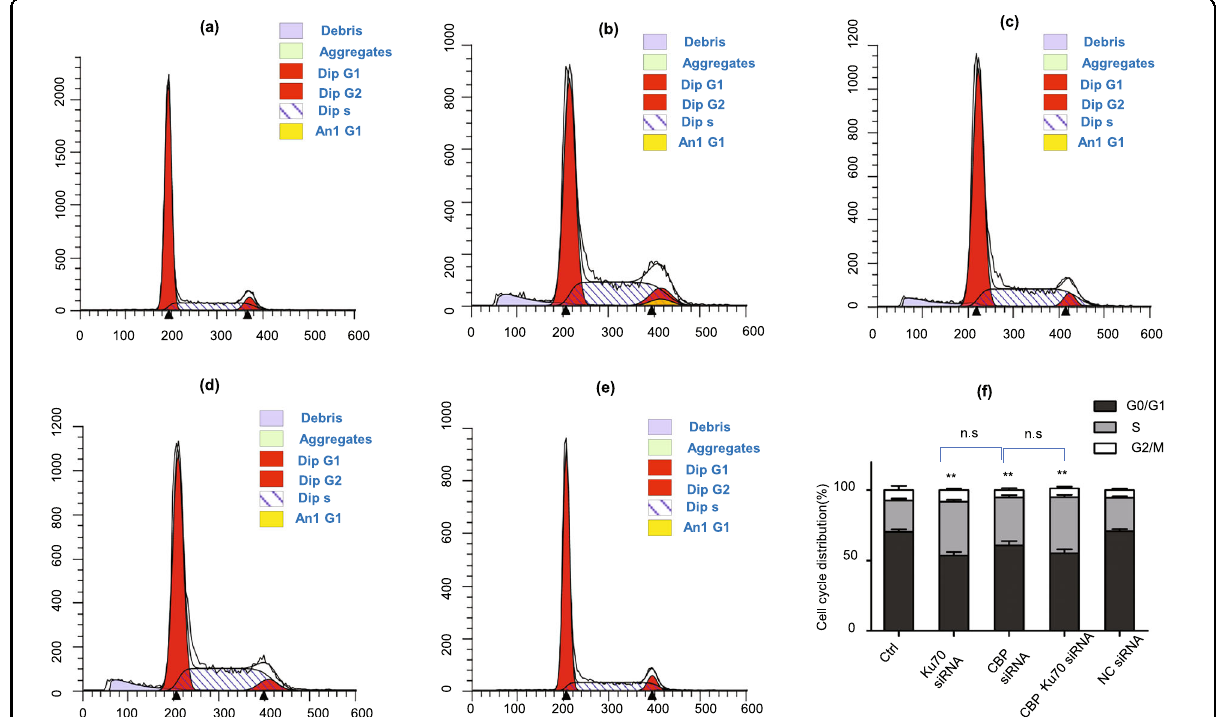
Fig. 7 Depletion of CBP and/or Ku70 caused cell cycle arrest. a Control group. b Ku70 siRNA (70% depletion) group; c CBP siRNA (70% depletion) group; d co-transfections of CBP siRNA and Ku70 siRNA (60% depletion for CBP and Ku70, respectively). e NC siRNA group; f cell cycle of different groups of A375 cells. Data as shown in the fi gures were expressed as mean ± SEM ( n = 3). * P < 0.05, ** P < 0.01, # P < 0.05, ## P < 0.01, and n.s denotes P >